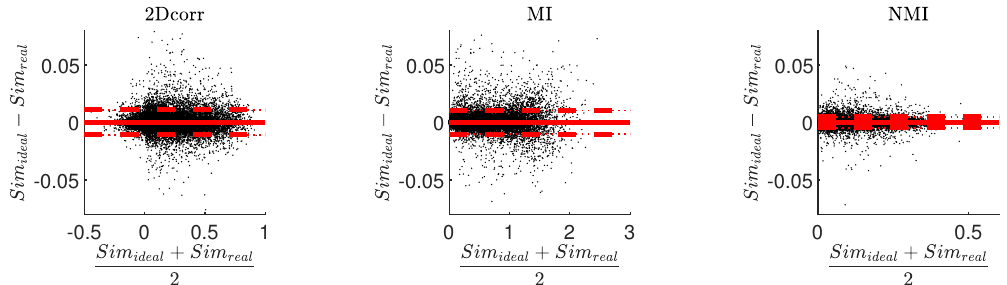
Figure 12. Bland-Altman plots comparing metric behavior under real and idealized conditions. Sim ideal : similarity measured between each perturbed frame and the stable version of itself; Sim real : similarity measured between each perturbed frame and the previous stable frame. Black dots are individual random samples along all studied scenarios; red solid lines indicate mean bias; red dashed lines indicate Limits of Agreement (LoA); red dotted lines represent 95% confidence intervals for estimated bias and LoA. Wide LoA are representative of significant sensitivity to changes in the reference frame used for